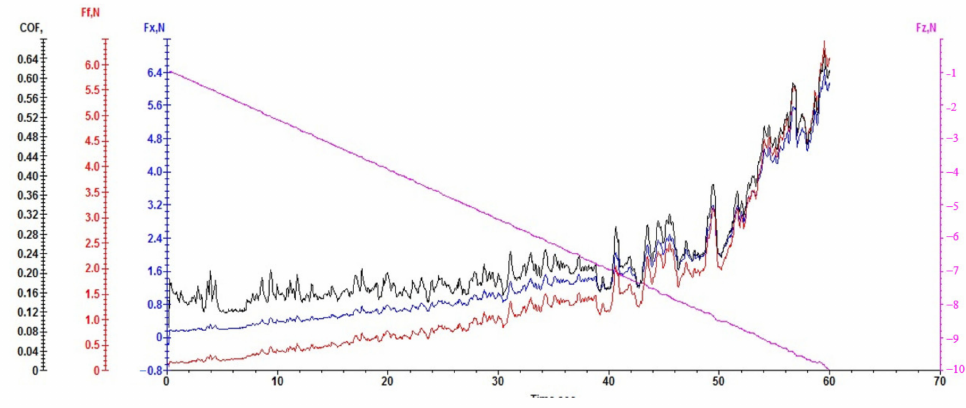
Figure 8. Photograph of the non-phosphate nodular cast iron specimen after the scratch